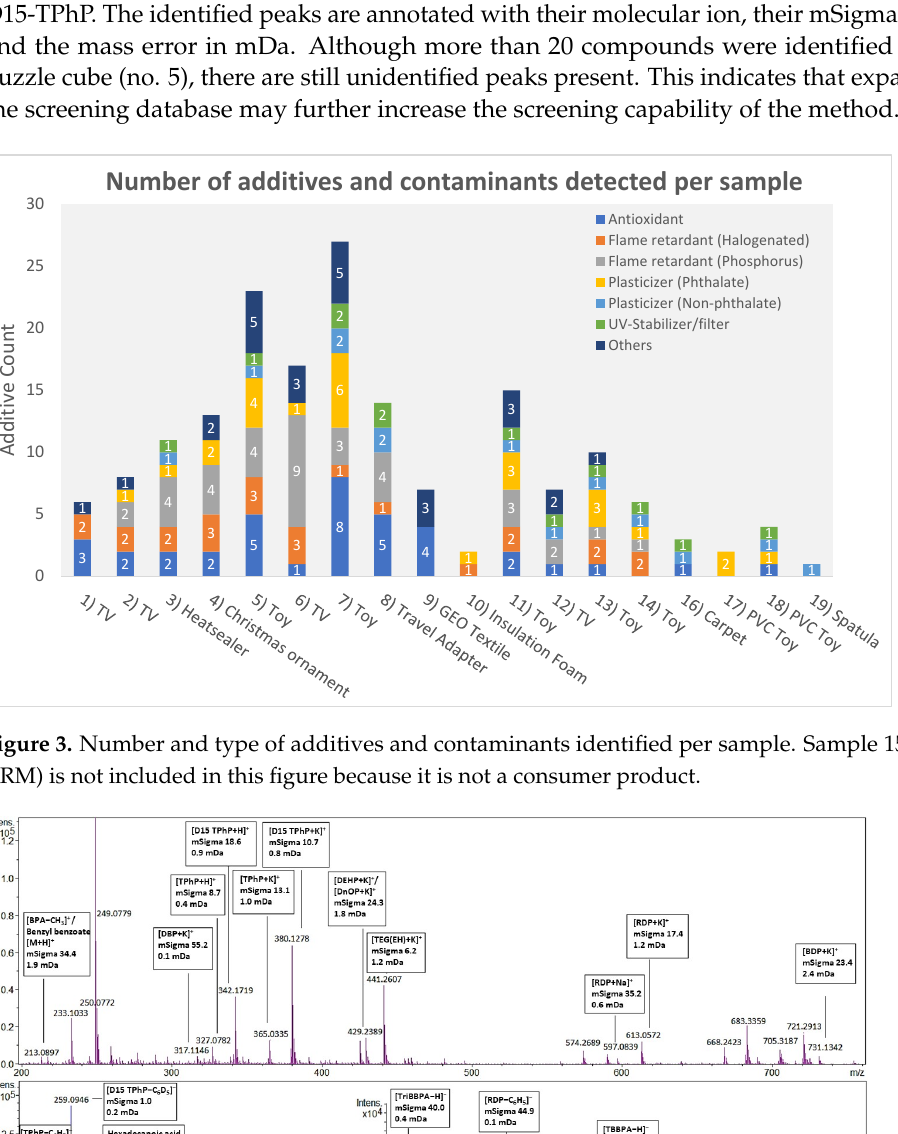
Figure 2. AP-MALDI-qTOF-MS full scan mass spectrum of a PVC CRM (KRISS 113-03-006) extract, measured on a GNP-doped AP-MALDI target. The extract has been spiked with 125 mg L − 1 labeled D15-TPhP. Peaks are annotated with their molecular ion and mass error in mDa. All annotated peaks have mSigma values below 100.